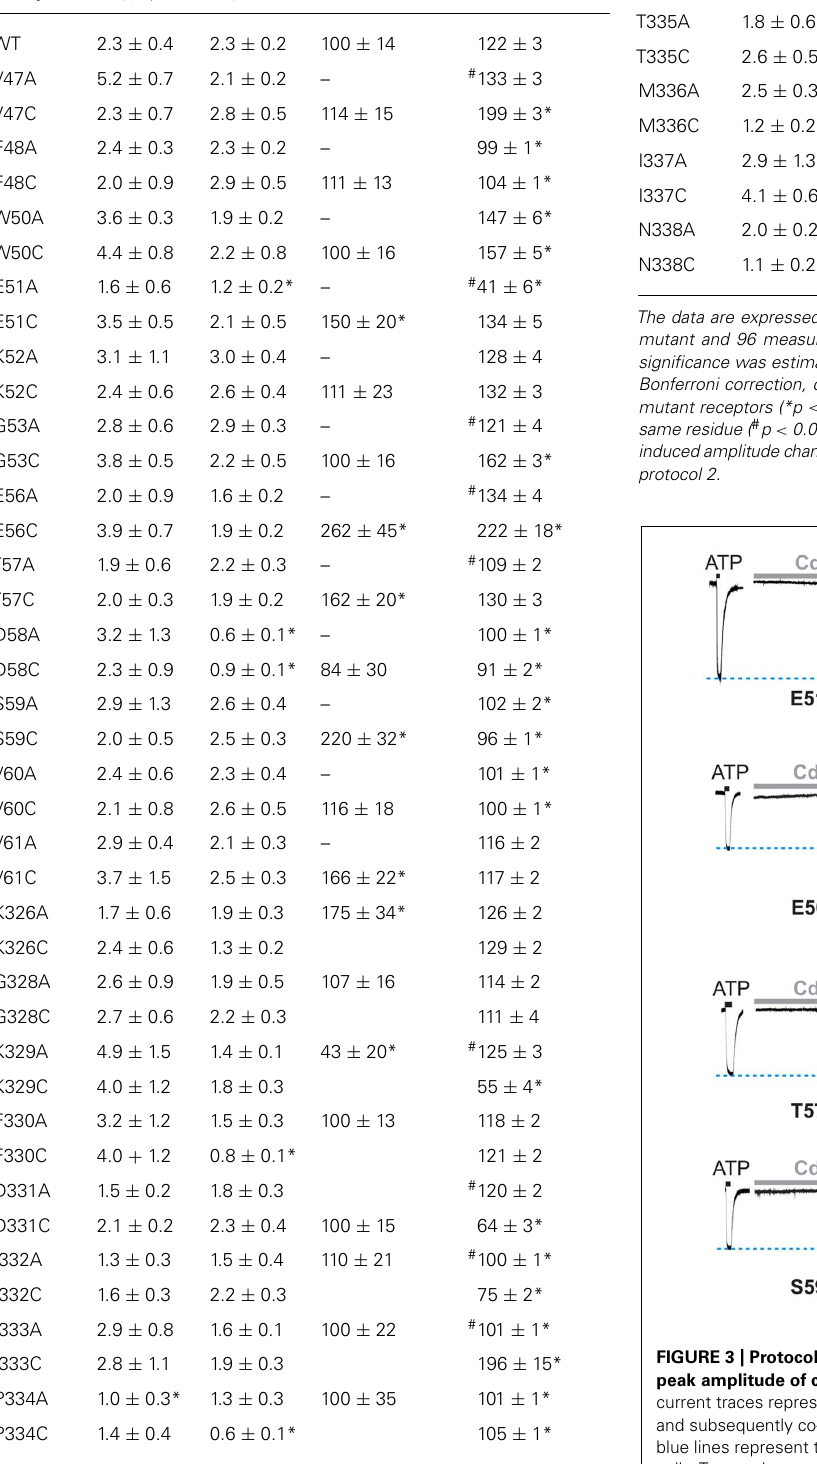
Table 1 | Effect of pre-application and co-application of cadmium ion on alanine and cysteine rP2X4R mutants. Receptor EC 50 ( μ M) I max (nA)